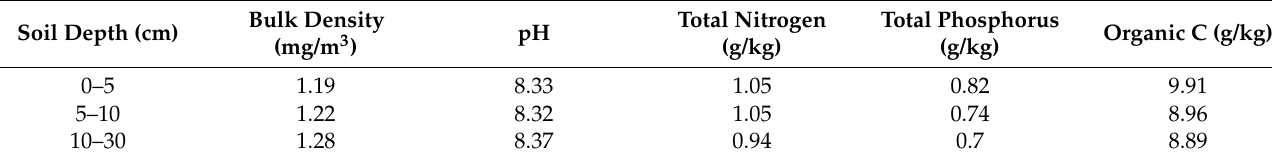
Table 1. Initial physiochemical properties in the soil before experimental setup